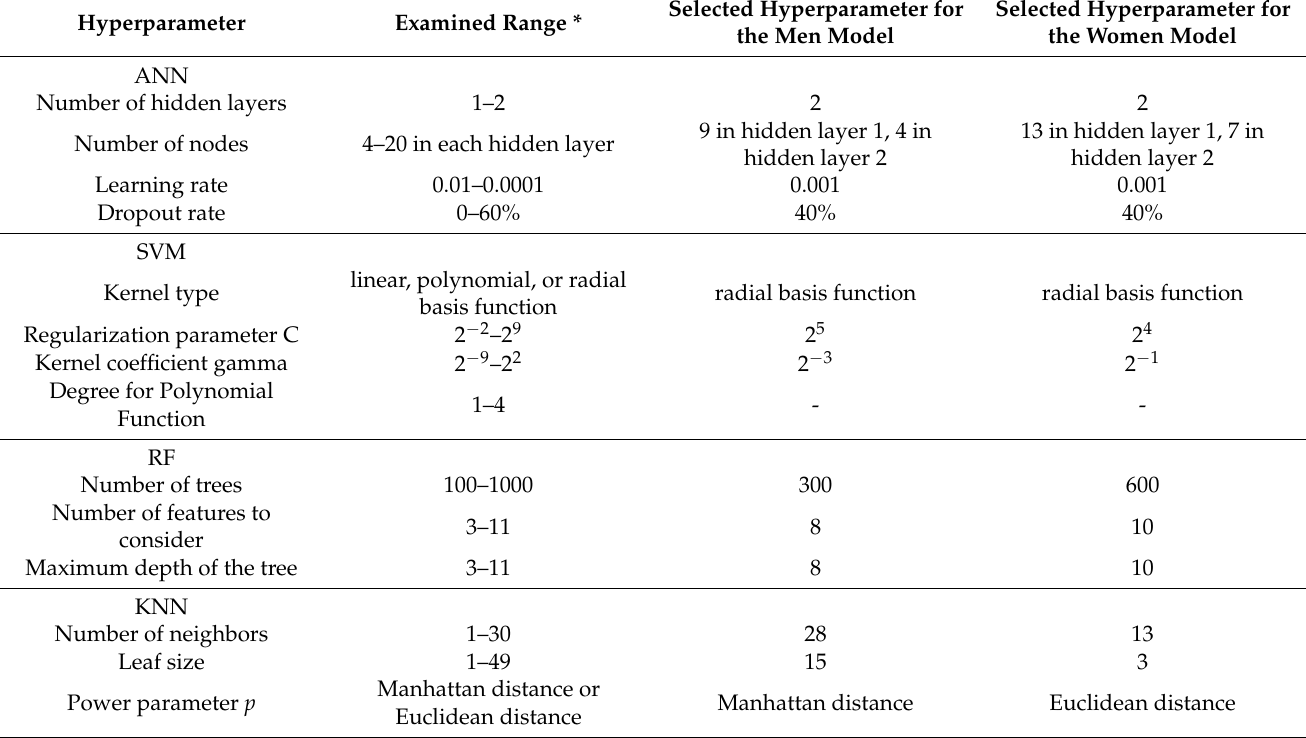
Table 1. Selection of hyperparameters for the ANN, SVM, RF, and KNN